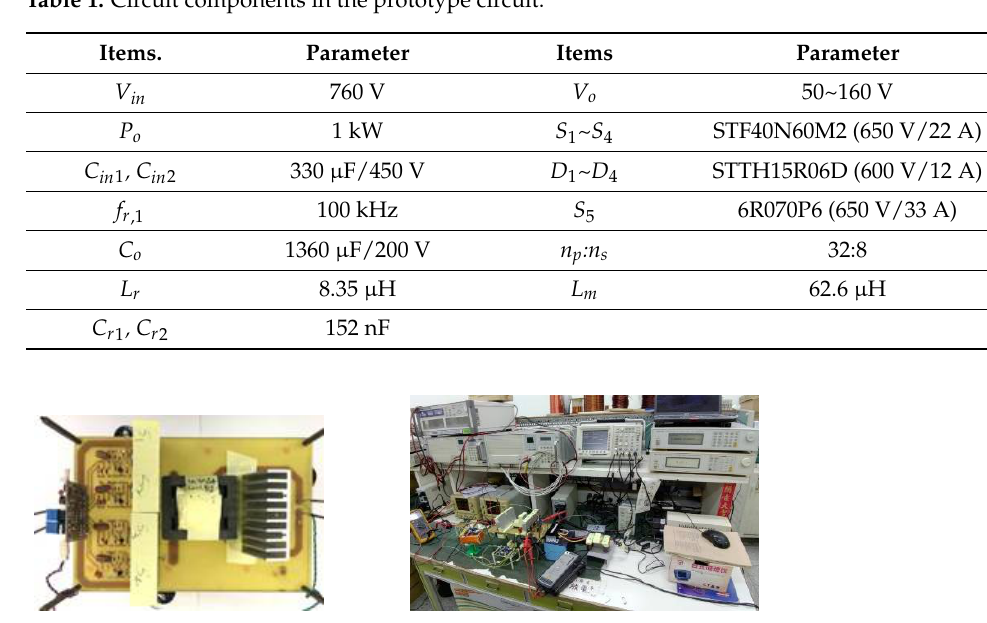
Table 1. Circuit components in the prototype circuit.